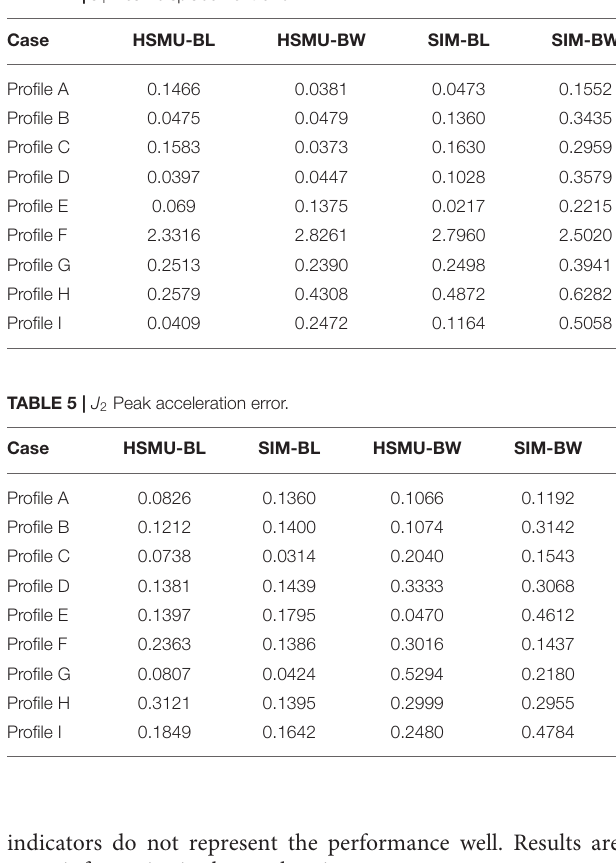
TABLE 4 | J 1 Peak displacement error.